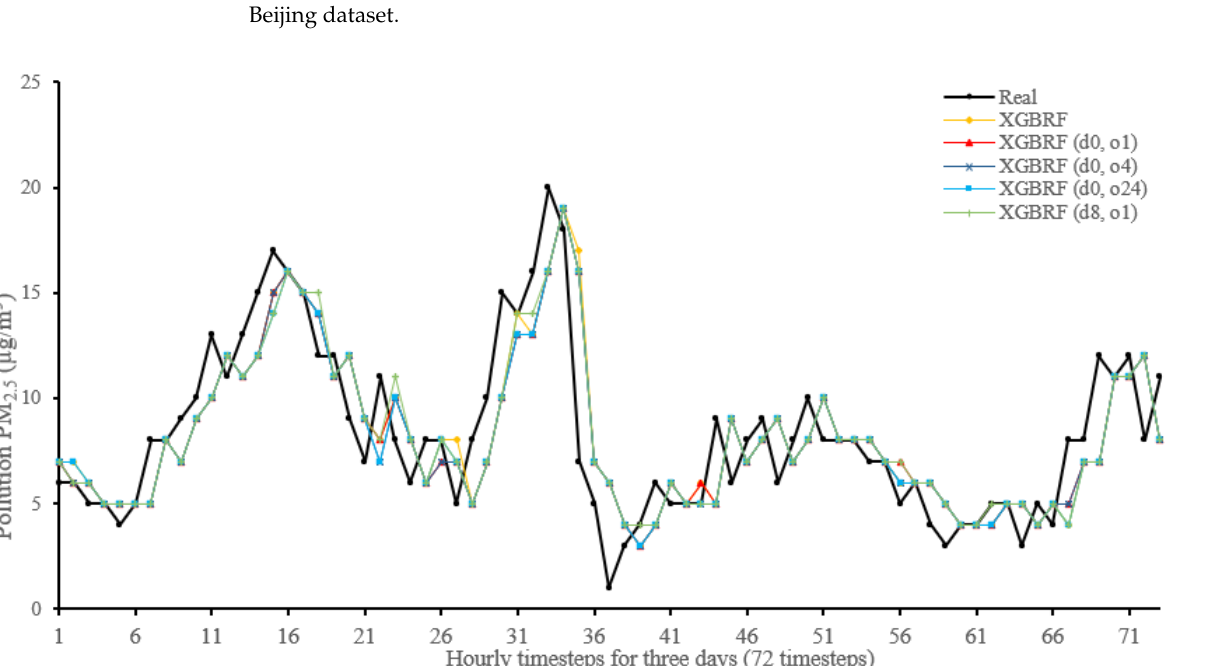
Figure 21. Real vs. XGBRF and its NARX variants in part of the seventh iteration results for the Manchester dataset.